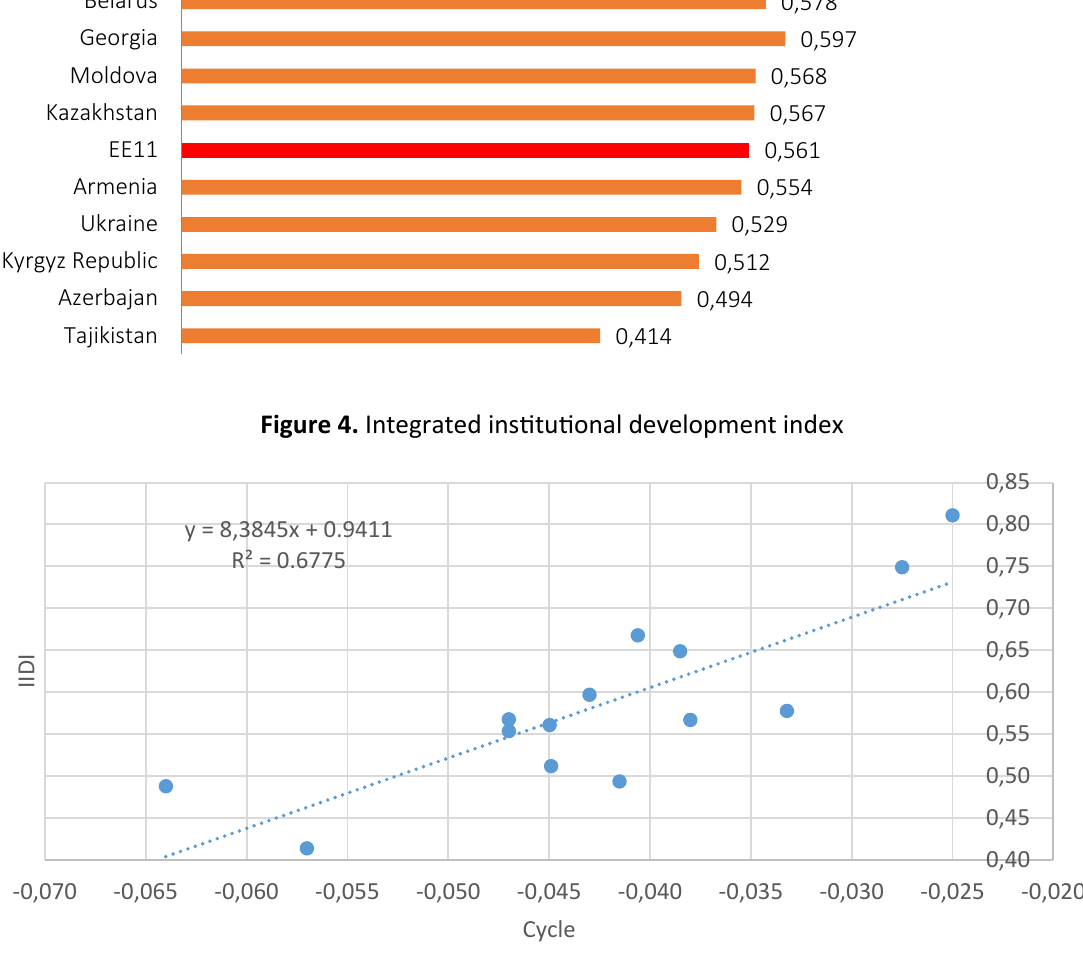
Figure 5. Plot diagram IIDI and GDP contraction during financial crisis